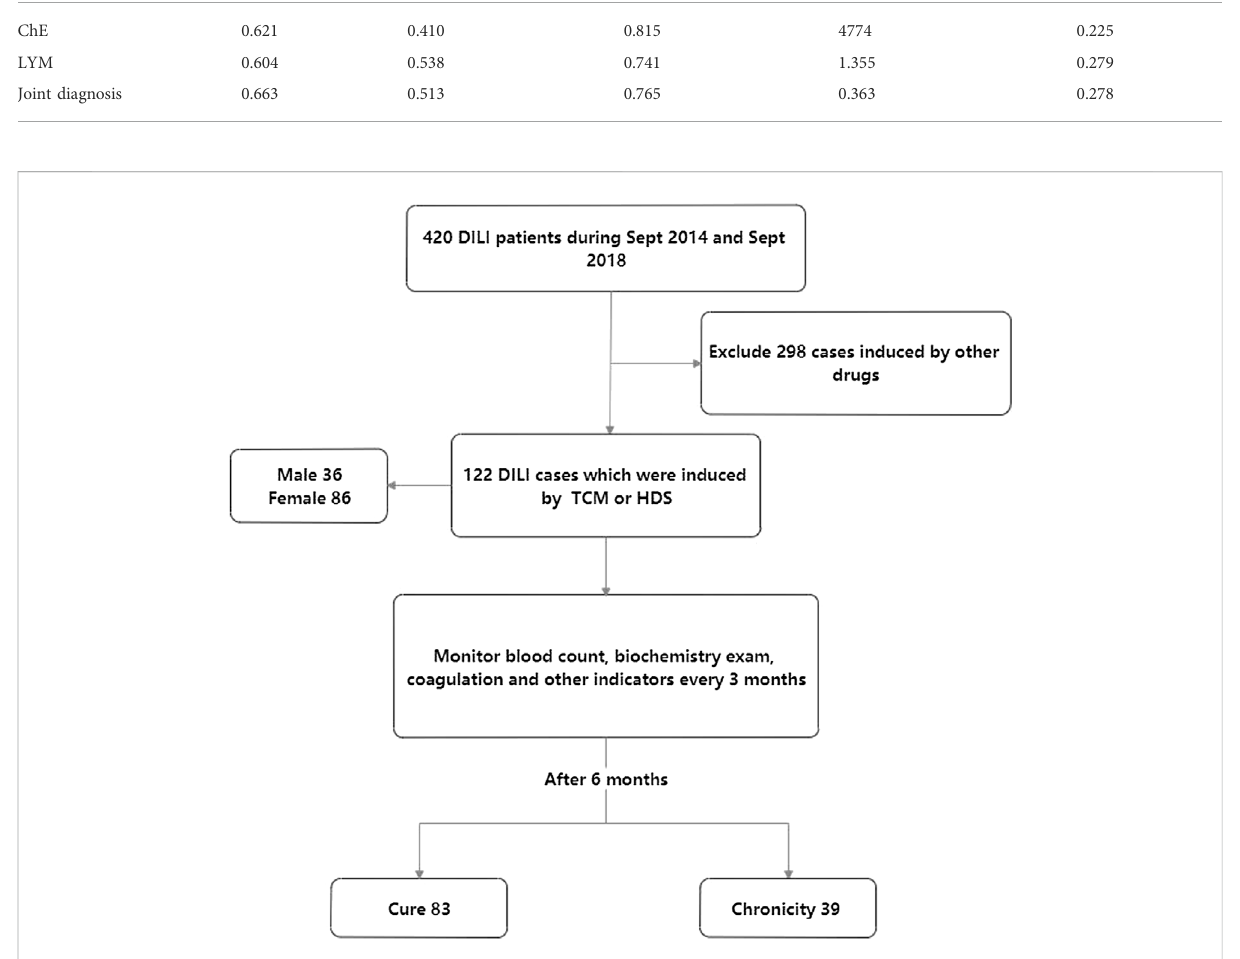
FIGURE 1 Enrollment of trial